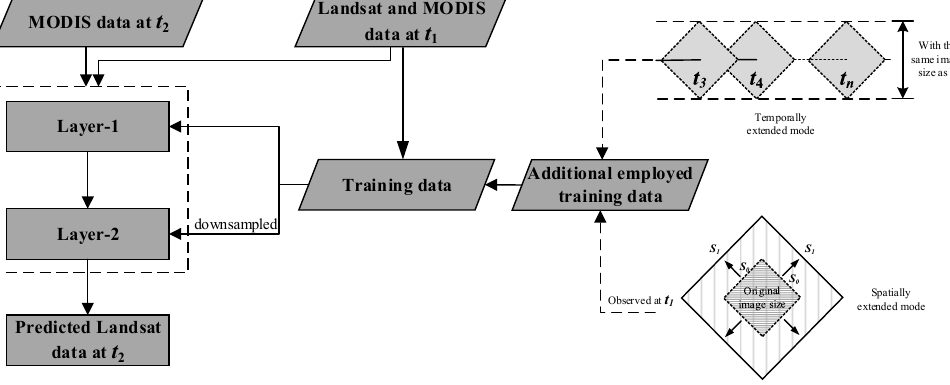
Figure 1. The proposed fusion scheme with spatially or temporally extended samples in dictionary training.